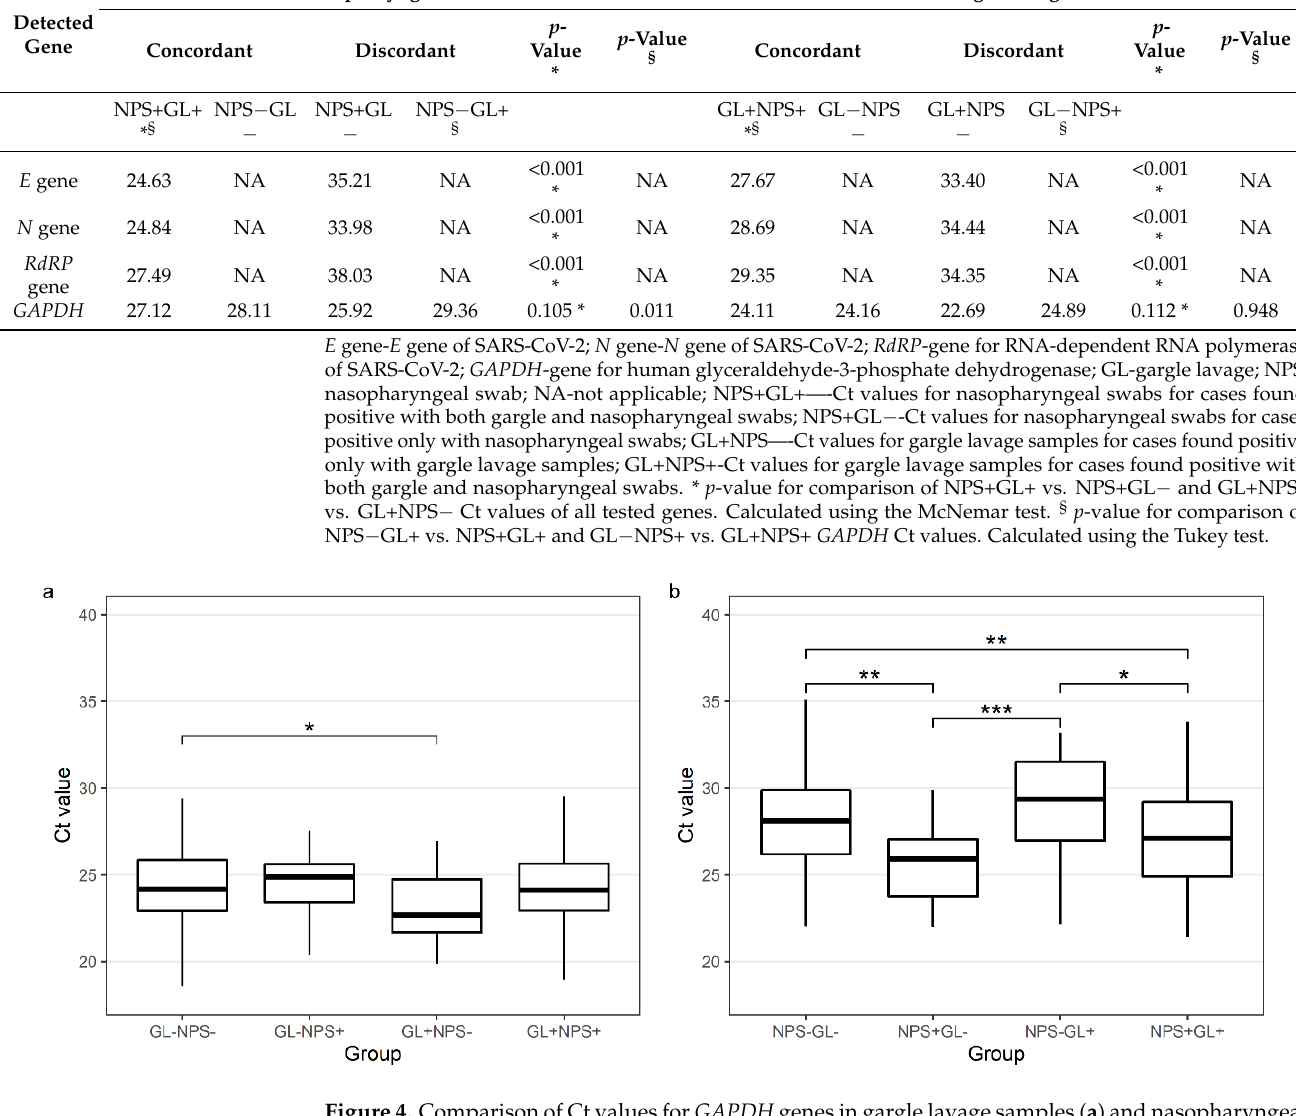
Figure 4. Comparison of Ct values for GAPDH genes in gargle lavage samples ( a ) and nasopharyngeal swabs ( b ) with concordant and discordant results ( a ) GL − NPS − - GAPDH Ct values for gargle lavage samples for cases found negative with both gargle and nasopharyngeal swabs; GL − NPS+- GAPDH Ct values for gargle lavage samples for cases found positive only with nasopharyngeal swabs; GL+NPS − - GAPDH Ct values for gargle lavage samples for cases found positive only with gargle lavage samples; GL+NPS+- GAPDH Ct values for gargle lavage samples for cases found positive with both gargle and nasopharyngeal swabs. ( b ) NPS − GL − - GAPDH Ct values for nasopharyngeal swabs for cases found negative with both gargle and nasopharyngeal swabs; NPS+GL − - GAPDH Ct values for nasopharyngeal swabs for cases found positive only with nasopharyngeal swabs; NPS − GL+- GAPDH Ct values for nasopharyngeal swabs for cases found positive only with gargle lavage samples; NPS+GL+- GAPDH Ct values for nasopharyngeal swabs for cases found positive with both gargle and nasopharyngeal swabs. Calculated by the Tukey test (after ANOVA). * p < 0.05, ** p < 0.01, *** p < 0.001. There was good agreement for SARS-CoV-2 detection between the self-sampled GL samples and the conventional NPS samples with an overall accuracy of 91.9%